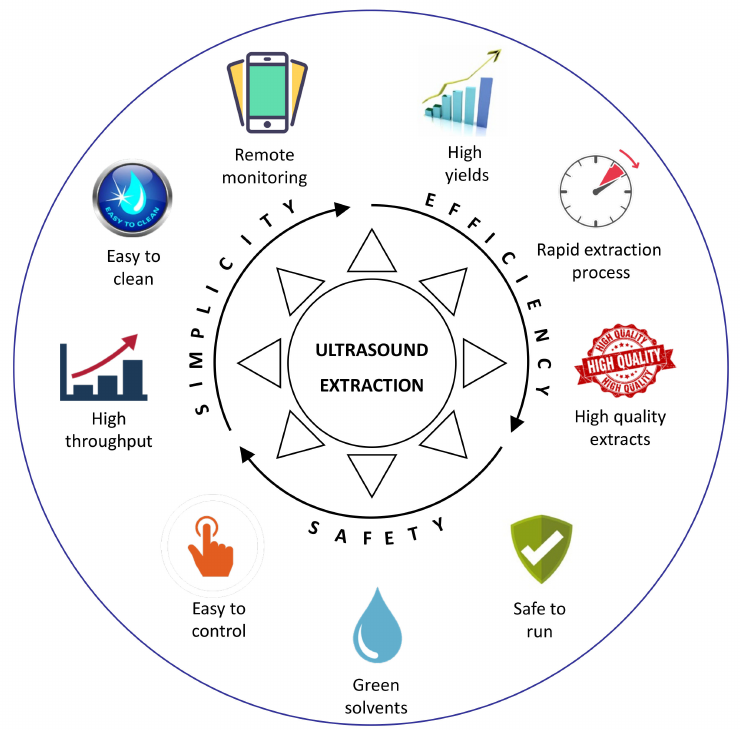
Figure 1. Advantages of ultrasound technology for the extraction of target